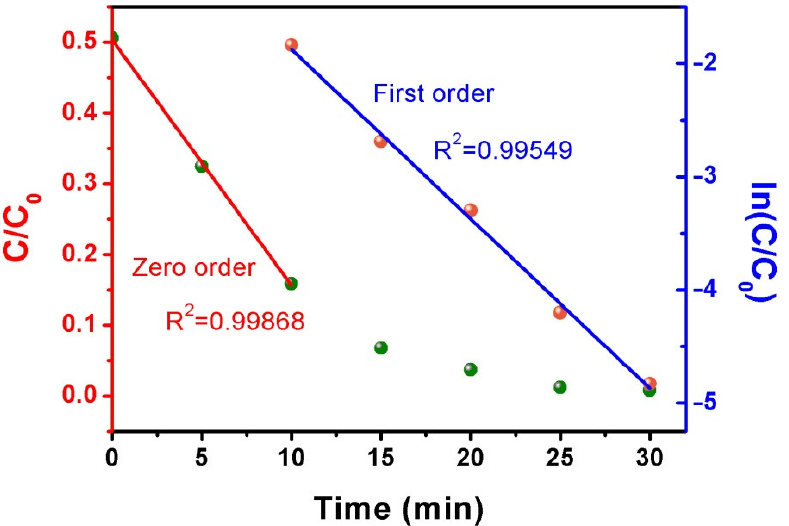
Figure 9. The photocatalytic degradation of MB on EVC-2 under 40 W LED irradiation: the corre- sponding zero-order kinetics curve (left) and the first-order kinetics curve (right).